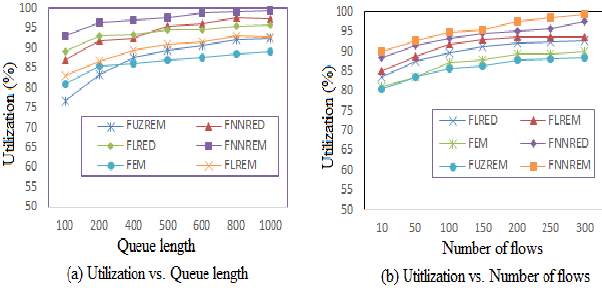
Figure 18. Link Utilization level of AQM mechanisms Based on the graph, find the partition mechanism on the level of traffic. In both graphs of Figure 18, the level of use of transmission is increased from group mechanisms using traditional fuzzy controller (such as FEM, FUZREM), followed by a group of mechanisms used controller AFC adaptive fuzzy (as FLRED, FLREM) to group the mechanism used fuzzy controller FNN (as FNNRED, FNNREM). This is consistent with the results of theoretical analysis, the AFC using Sugeno fuzzy systems have mechanisms to adjust output parameters K and the method of determining the form G m for the target value, and FNN is built from AFC by train to get the value for the parameter